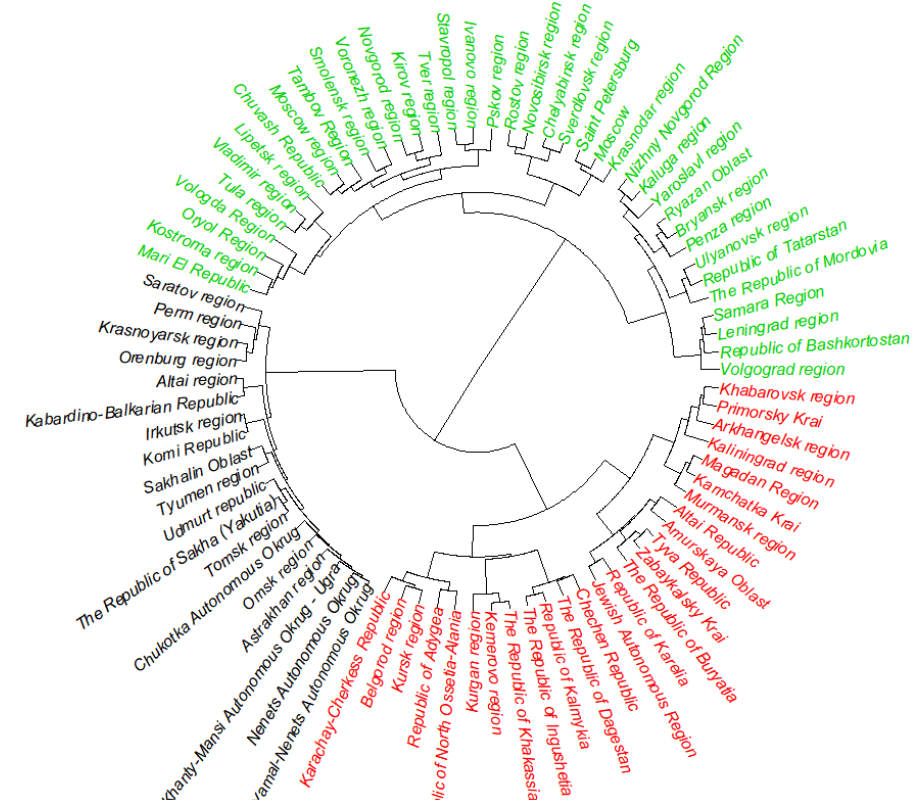
Figure 5. Hierarchical classification tree, 2017.